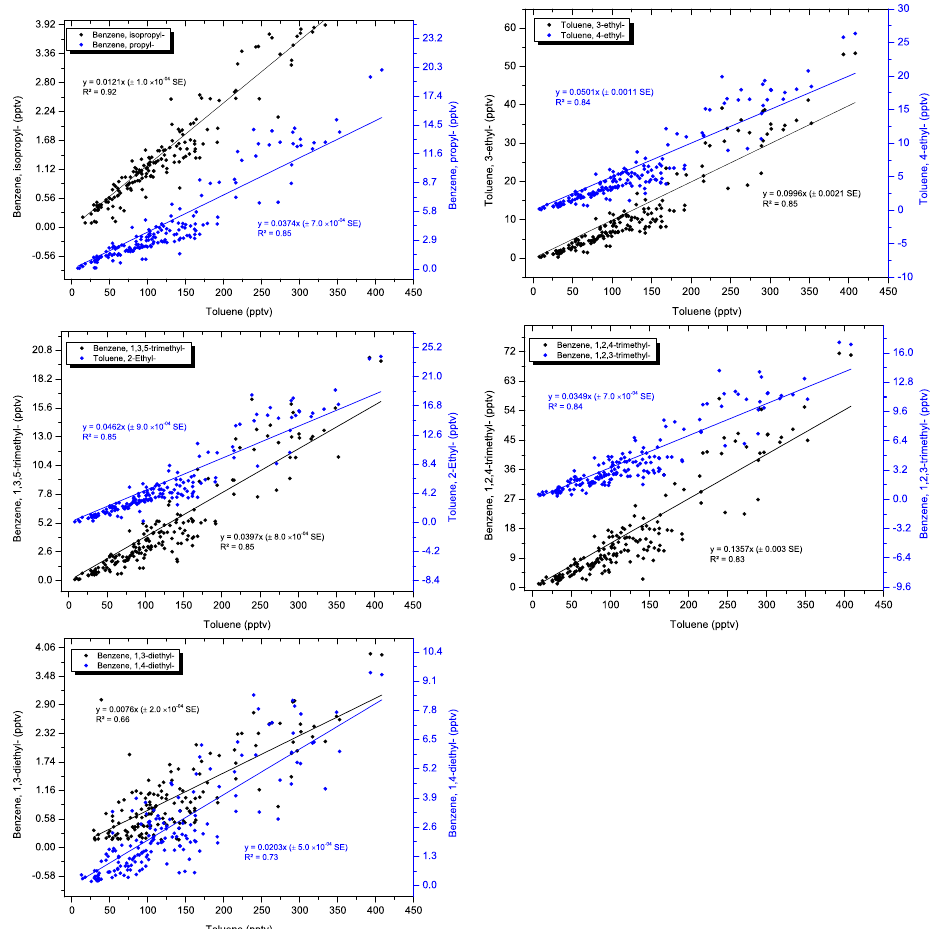
Figure 6. Plots of monoaromatic mixing ratios from each WAS canister against the simultaneous toluene mixing ratio observed. The coefficient of determination and equations of the linear regressions are also given and are also summarised in Table 3.